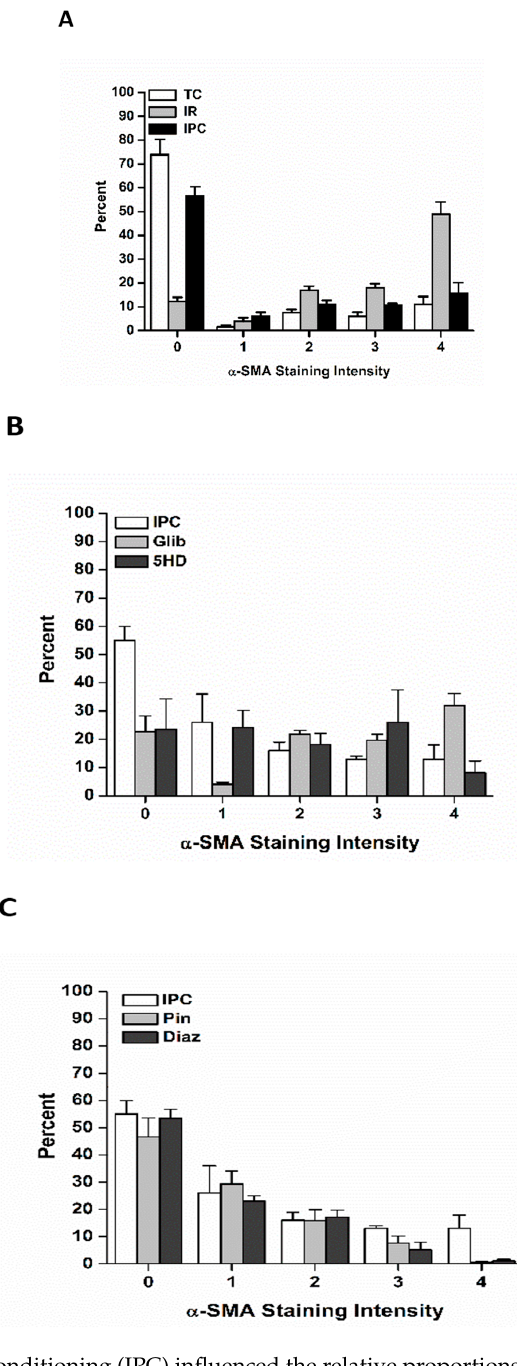
Figure 9. Ischemic preconditioning (IPC) influenced the relative proportions of immature vs. mature myofibroblasts. ( A) : IPC (black bars) was associated with a significantly higher percentage of fibroblasts ( α smooth muscle actin ( α -SMA) staining intensity 0) and fewer fully mature myofibroblasts ( α -SMA staining intensity 4) and a trend for immature myofibroblasts ( α -SMA staining intensities 1–3). These trends were also observed when IPC was mimicked by opening K ATP channels with pinacidil (Pin) ( B ) or diazoxide (Diaz) ( B ). In contrast, blocking K ATP channels with either glibenclamide (Glib) ( C ) or 5-hydroxydecanoate (5HD) ( C ) was associated with fewer fibroblasts ( α -SMA staining intensity 0) than following IPC ( B , C